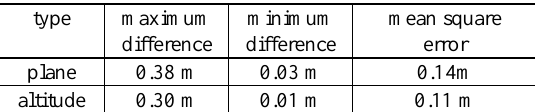
Figure 9. Differential diagram of on-board satellite station